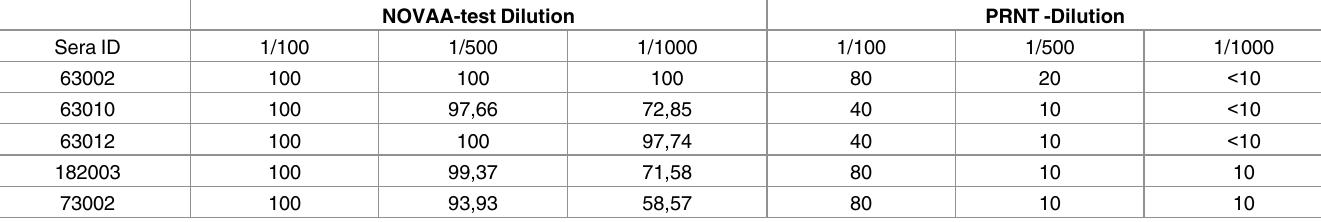
Positivity criteria: 90–100% (bolded numbers) neutralizing activity in the NOVAA-test is considered significant; 75–89% is considered indeterminate;